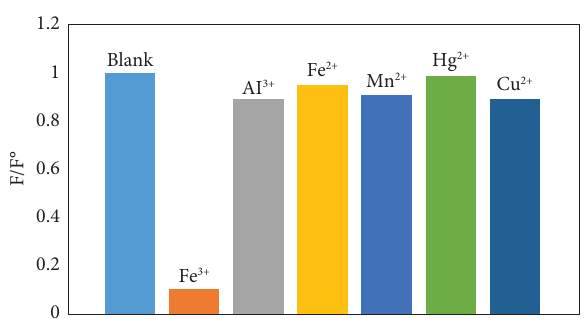
Table 3: Determination of ascorbic acid in the real